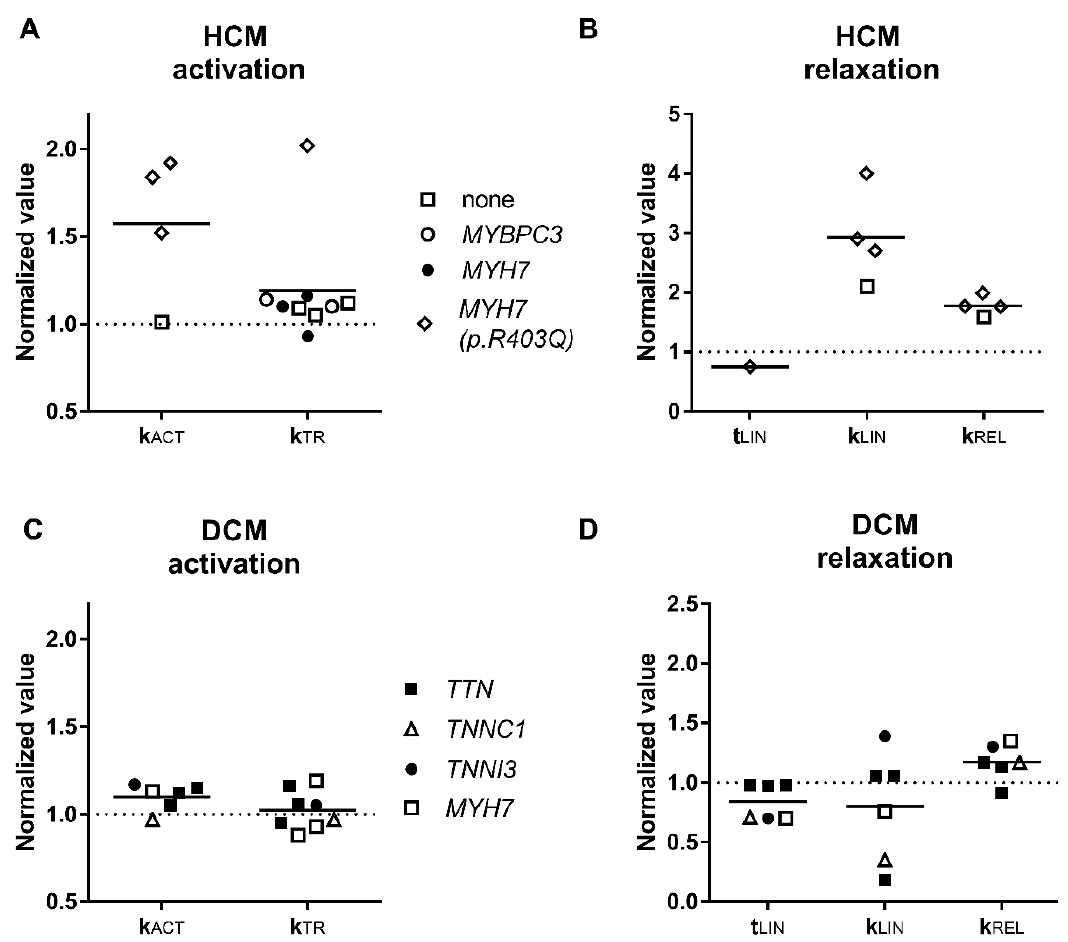
Figure 2. Contractile kinetics parameters. Parameters of activation ( A , C ) and relaxation ( B , D ) kinetics of HCM and DCM muscle samples. Each data point represents a different experimental group where the symbols indicate genes where mutations were found. All values are normalised to those of donor heart muscle. See also Tables 1 and 2.